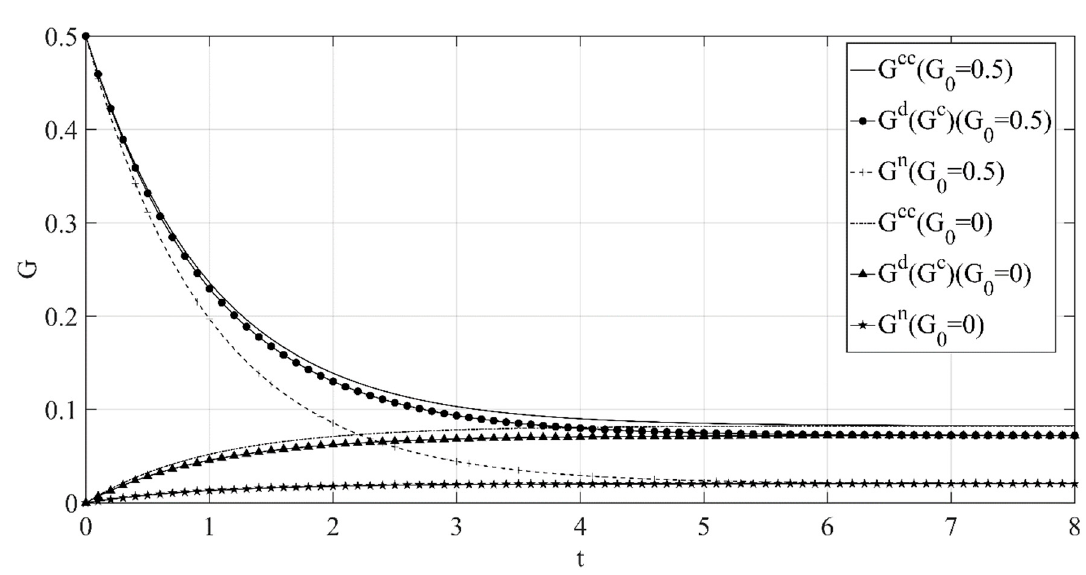
Figure 2. The optimal path of low-carbon goodwill over time.